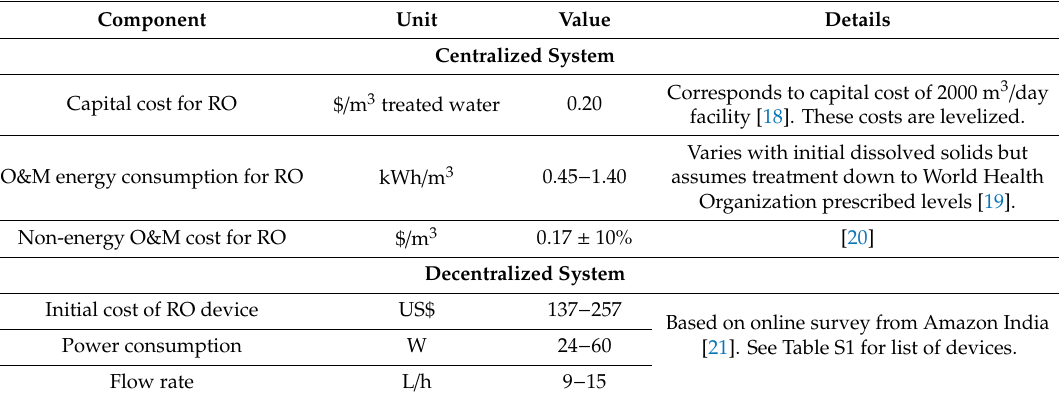
Table 1. Important assumptions for estimation of life cycle